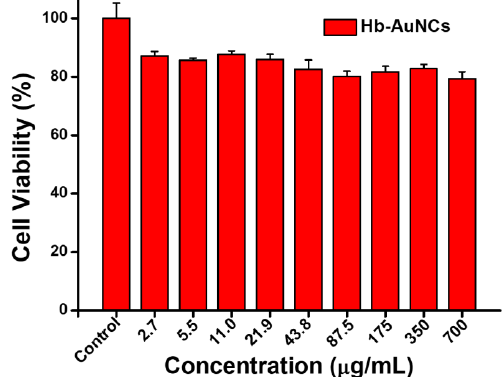
Figure 4. Cell viabilities of hemoglobin-conjugated gold nanoclusters (Hb-AuNCs) at concentrations of 2.7~700 μg/mL via a resazurin dye reduction assay.